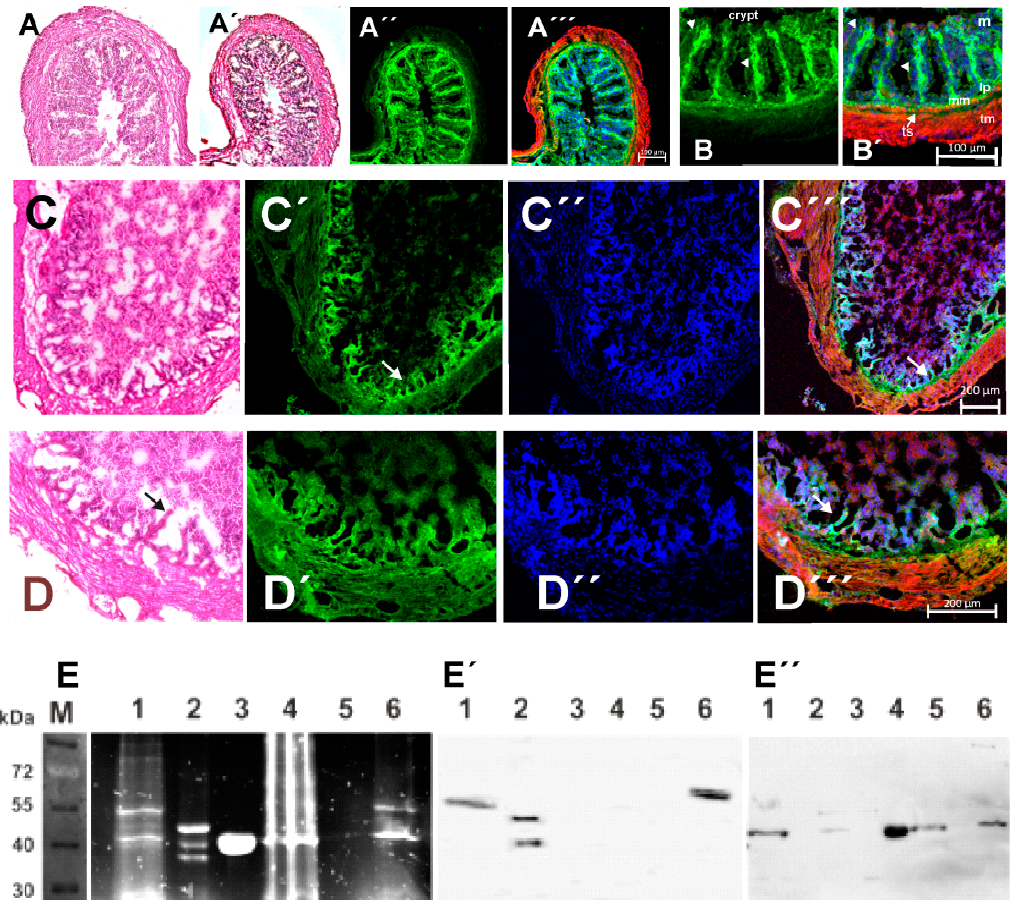
Figure 7. Effect of C. difficile CDTa and CDTb toxins on the mucosa of mouse colon. Mouse colon pieces filled with PBS alone ( A ) or plus 0.15 mM Triton X-100 (control) ( A ´ ) were ligated at both ends and incubated for 3 h at 37 ◦ C. ( A , A ´ ) Hematoxylin stained; note no gross alterations in the organization of the mucosa. ( A ´´ , B ) Consecutive sections stained with anti-Arp2 monoclonal antibody and ( A ´´´ , B ´ ) merged images with TRITC-phalloidin staining. Arrowheads point to weak anti-Arp2 staining of the enterocytes, in ( B ´ ) the intestinal layers are marked as detailed in text. ( C , D ). Sections of colon pieces were incubated for 3 h with PBS, 0.15 mM Triton X-100, the CDTa and CDTb toxin components both at 0.1 mg/mL, and 0.1 mM etheno-NAD. Triton X-100 was included to secure diffusion of etheno-NAD into the mucosal enterocytes. ( C , D ) Cryo-sections after 3 h incubation: ( C , D ) H.E. stained; ( C´ , D´ ) immunostained with anti-Arp2; ( C´´ , D´´ ) Hoechst 33342, and ( C´´´ , D´´´ ) merged images together with TRITC-phalloidin stain. Arrows point to anti-Arp2 positive remnants of the Lamina propria within of the crypts, whereas the enterocytes appear completely dissolved. For details see text. Bars in ( A´´´ , B´ ) represent 100 µm and in ( C , D ) 200 µm. ( E ) SDS-PAGE (12.5% polyacrylamide) of IP fractions of colon homogenates after exposure for 3 h to the CDTa and CDTb ( C. difficile ) components and 0.1 mM etheno-NAD analyzed for fluorescence, and Western blots im- munostained with anti-Arp2 ( E´ ), and anti-actin ( E´´ ). Lane 1: final IP fraction of colon segments treated for 2 h, lane 2 and 3: purified Acanthamoeba Arp2/3 complex and actin, both fluorescently